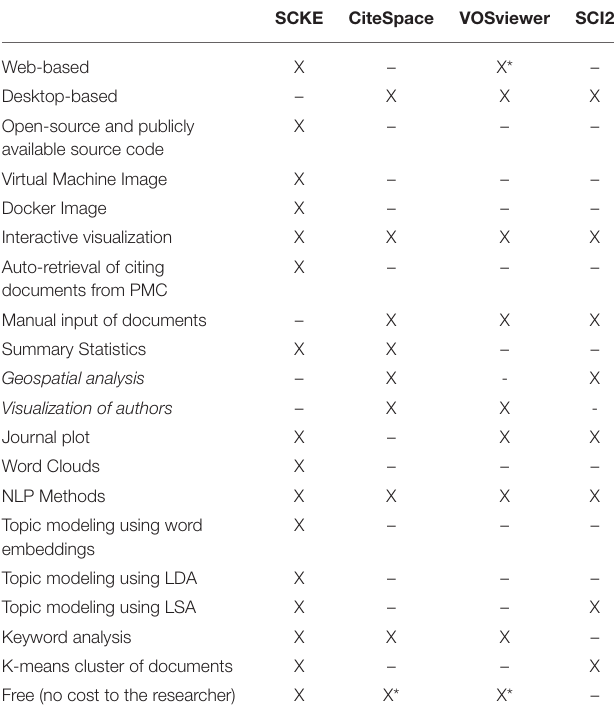
TABLE 1 | SCKE vs. Similar Software. A feature comparison between SCKE and three similar software packages; CiteSpace (Chen, 2006), VOSviewer (van Eck and Waltman, 2009), and SCI2 (Xiaohua et al., 2013). *VOSViewer is primarily intended to be downloaded, but can also be run as a web-based application if